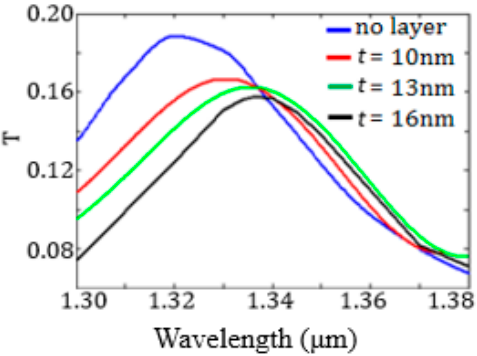
Figure 13. Transmission spectra of the plasmonic biosensor as a function of thickness t , corresponding to different values of biomarker concentration.